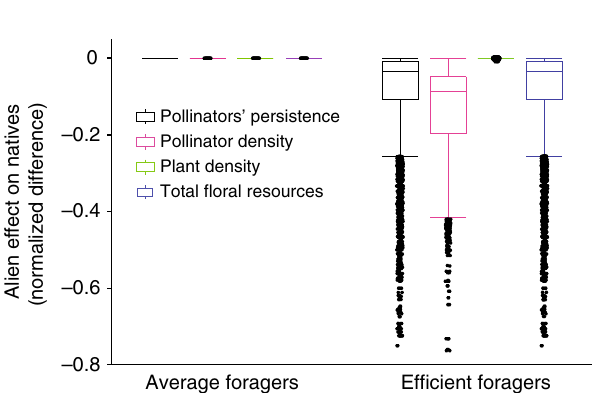
Fig. 1 Effects of alien pollinators on native species for all network structures. Effects exerted by average foragers (i.e., visitation rates equal to the mean visitation rate of native pollinators; left) were less negative than effects exerted by highly ef fi cient foragers (i.e., visit twice as many fl owers per unit time as do native pollinators on average; right). Effects were calculated as the normalized difference of native variables after and before the alien introduction, including (from left to right) persistence and total density of pollinator species, total density of plant species, and total fl oral resources. Effects displayed separately for alien pollinators that were average (four on the left) and ef fi cient foragers (right) using outlier box plots whose center line, box, and whiskers indicate the median, 75 – 25% quartiles, and 1.5